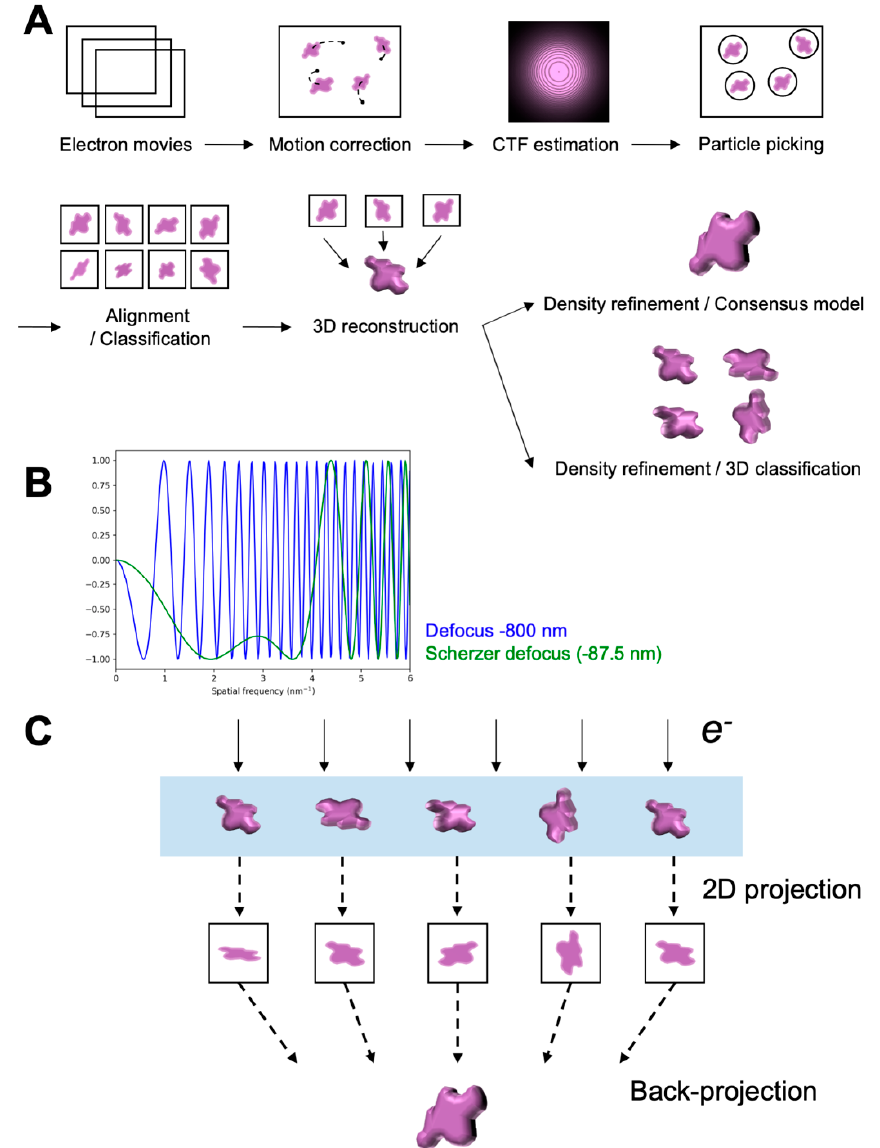
Figure 1. Schematics of the single-particle cryo-EM processing workflow. ( A ) General processing workflow for single-particle reconstruction workflow. ( B ) One-dimensional plot of the contrast transfer function (CTF) versus spatial frequency. Curves are calculated using an accelerated voltage of 300 keV and a spherical aberration coefficient ( Cs ) of 2.7 mm. Blue and green curves are for the defocus at − 800 and − 87.5 nm (Scherzer defocus), respectively. ( C ) Schematics of 2D projections from an imaged object and a 3D back-projection from the 2D projections. Light blue represents thin ice that embeds the particles in different orientations.